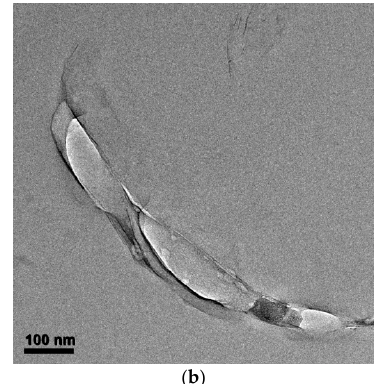
Figure 12. Scanning electron microscopy (SEM) micrograph of different fracture surfaces. ( a ) crack initiation site of neat epoxy; ( b ) fast fracture site of neat epoxy; ( c ) crack initiation site 2 wt % V-clay epoxy; ( d ) fast fracture site of 2 wt % V-clay epoxy; ( e ) crack initiation site of 2 wt % D-clay epoxy; and ( f ) fast fracture site of 2 wt % D-clay epoxy.